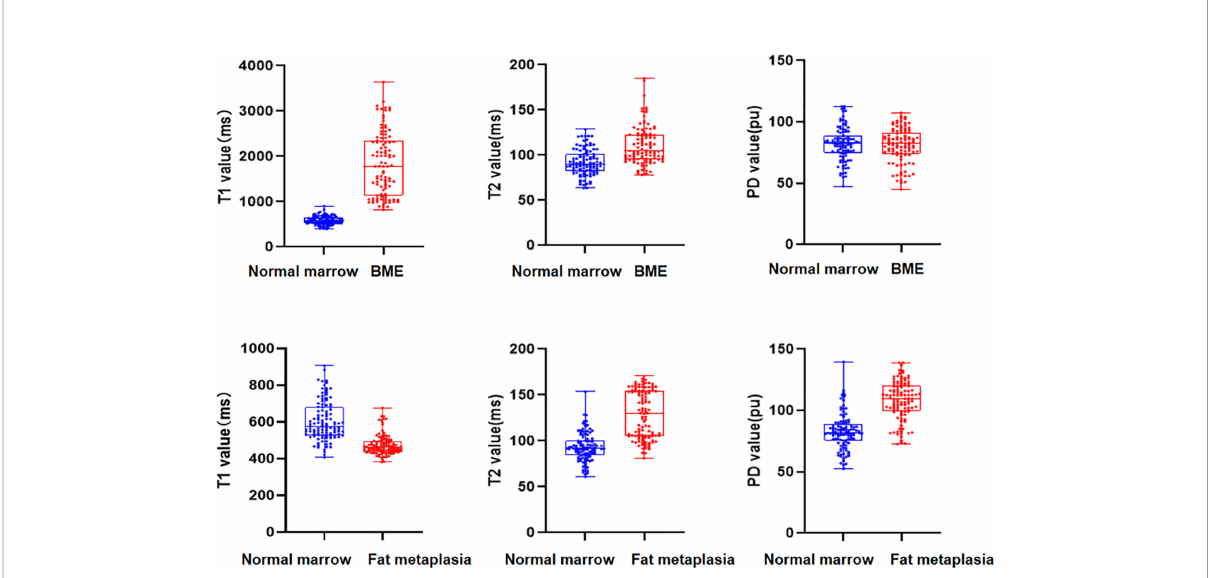
FIGURE 2 Box scatterplots show T1, T2, and proton density (PD) values in normal marrow and bone marrow edema (BME)/fat metaplasia of the sacroiliac joint in axial spondyloarthritis (axSpA) patients.